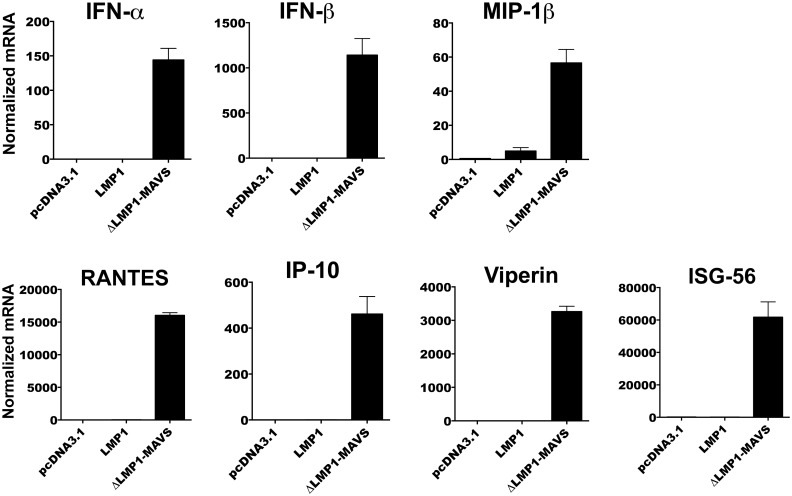
RealTime PCR analysis of 293T cells transfected with LMP1 or ΔLMP1-MAVS.293T cells were transfected with pcDNA3.1, LMP1 plasmid, or ΔLMP1-MAVS plasmid and total RNA isolated following 36-hour culture. Normalized expression was determined relative to the pcDNA3.1 control.